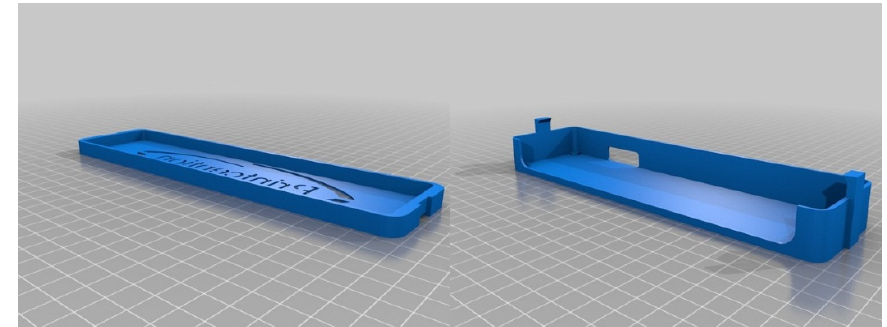
Figure 6. Rendering of OpenSCAD solid model for Melzi board electronics cover.